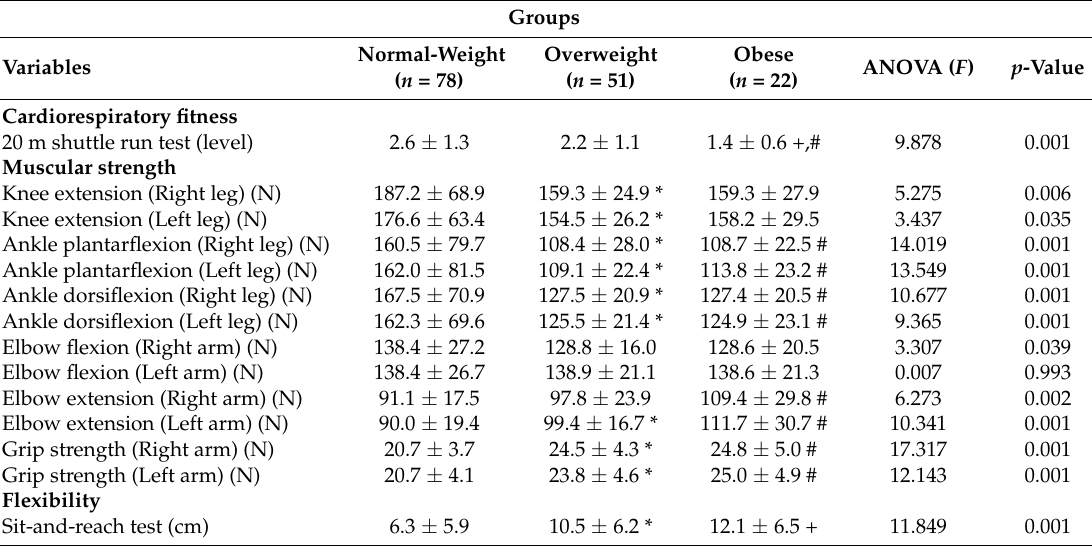
Table 2. Comparison of cardiorespiratory and musculoskeletal fitness among groups. Groups